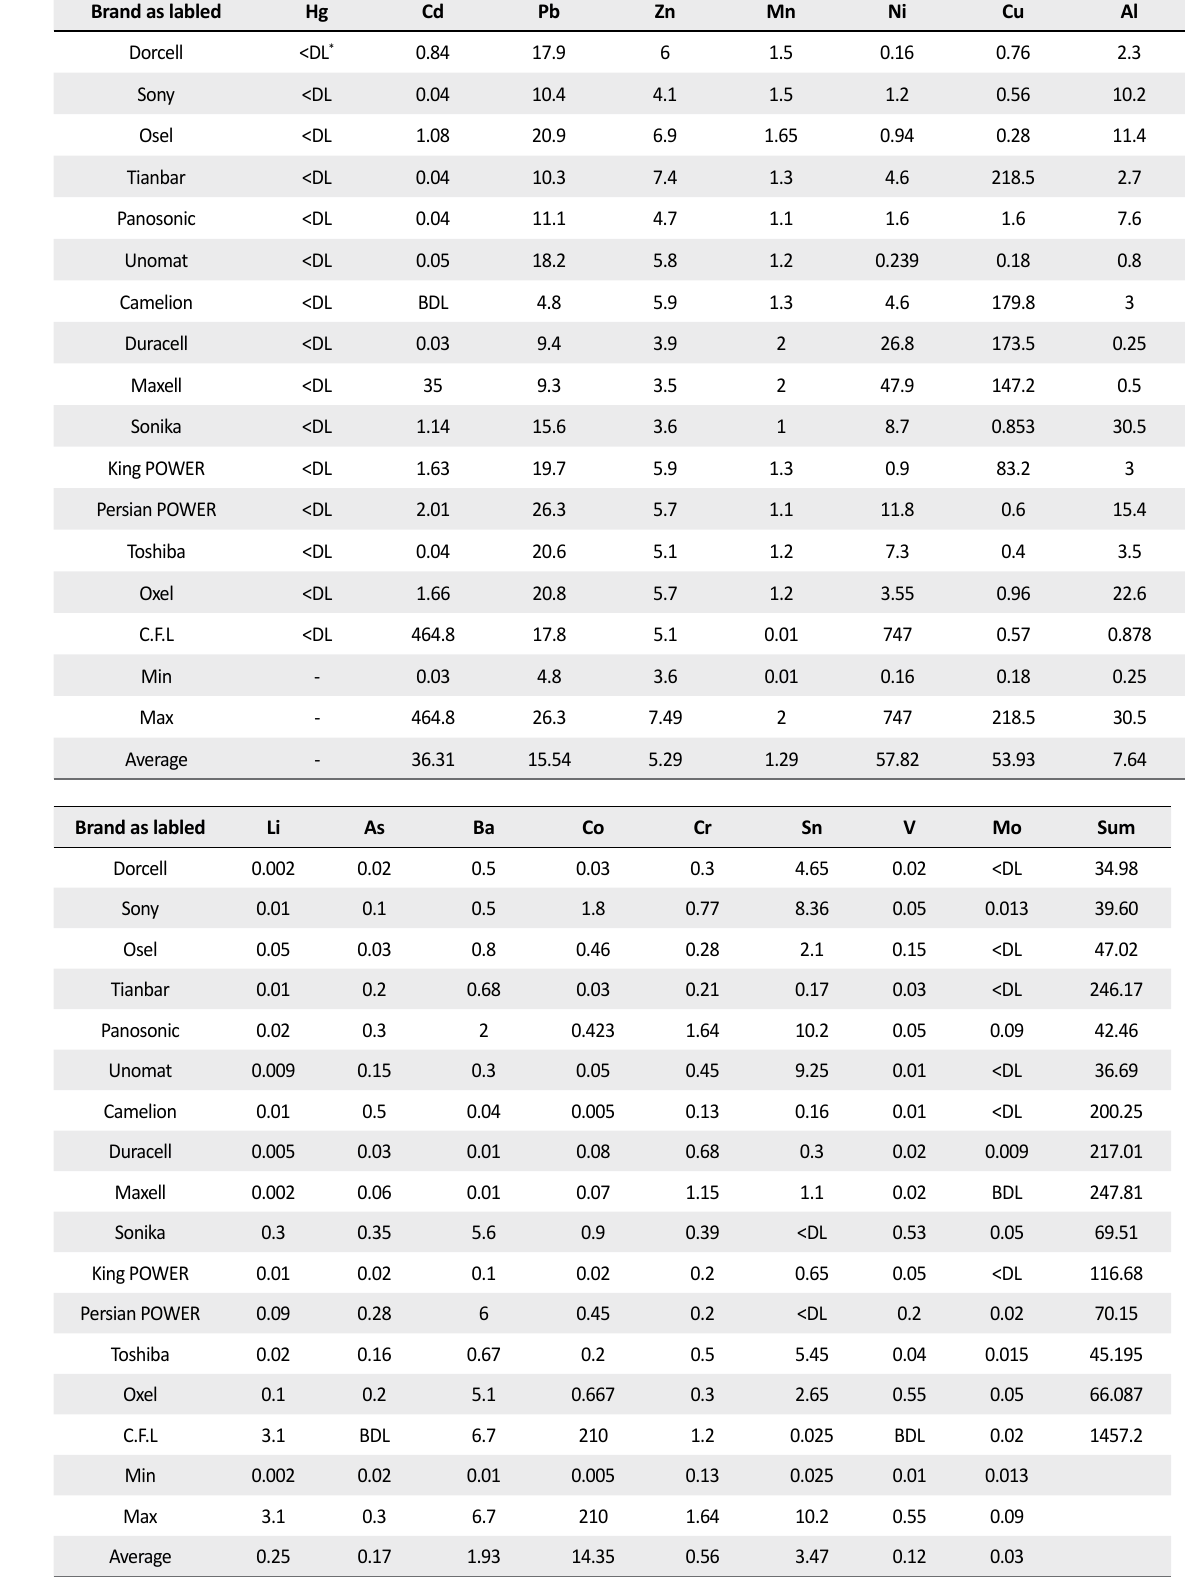
Table 5. Heavy metal contents of the used batteries (mg/kg dry weight) Brand as